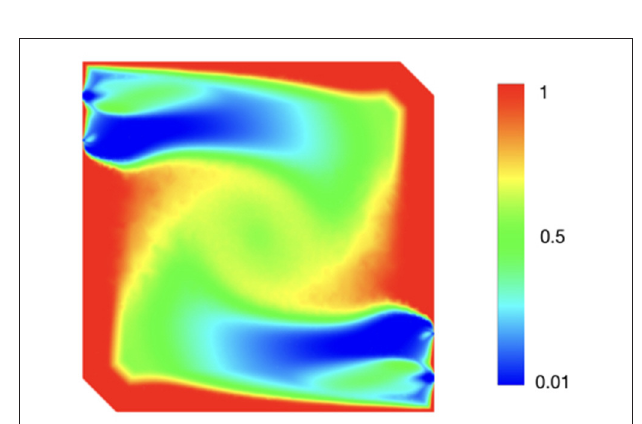
FIGURE 7 | Case 1 C mix